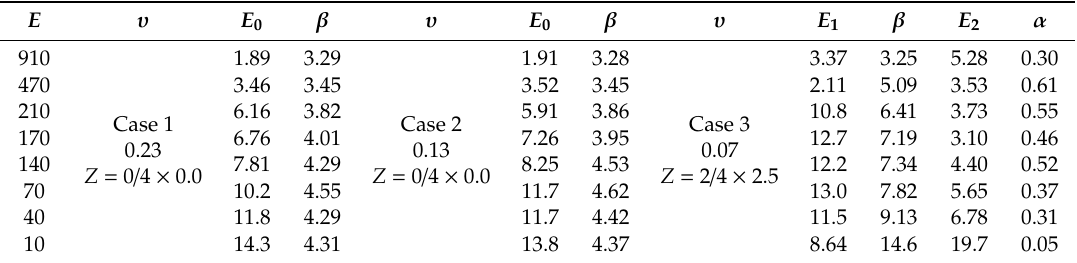
υ β υ β at different E and , with R = 5, L = 30. at different E and , with R = 5, L = 30.